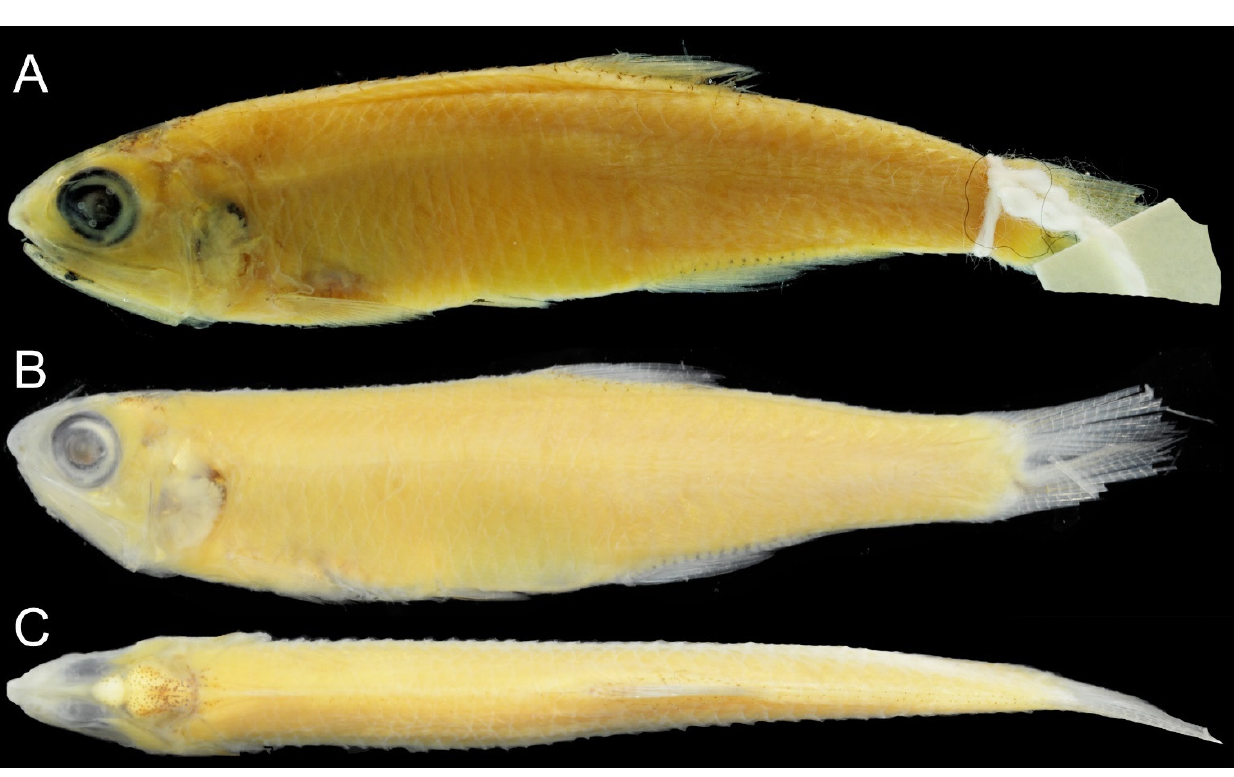
Figure 1. ( A ) Lateral view of the holotype of Stolephorus ronquilloi (BMNH1969.5.30.88, 48.7 mm SL; Luzon, Philippines); ( B ) lateral and ( C ) dorsal views of the non-type specimen (USNM 23845, 44.3 mm SL, Luzon, Philippines). Table 1. Meristics of specimens of Stolephorus ronquilloi and Stolephorus hindustanensis n. sp. Bold characters indicate non-overlapping meristics between the two species.